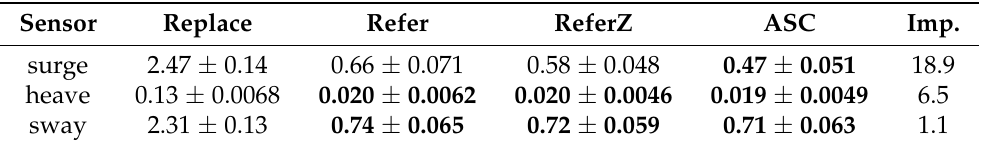
Table 3. Reconstruction errors (RMSE) on UUV data for individual sensor changes. Each entry shows the average reconstruction error and the corresponding standard error. Imp. shows the average improvement (in %) of ASC over the best baseline method. The best performing method(s) (statistically significant up to one standard error) are in bold font.